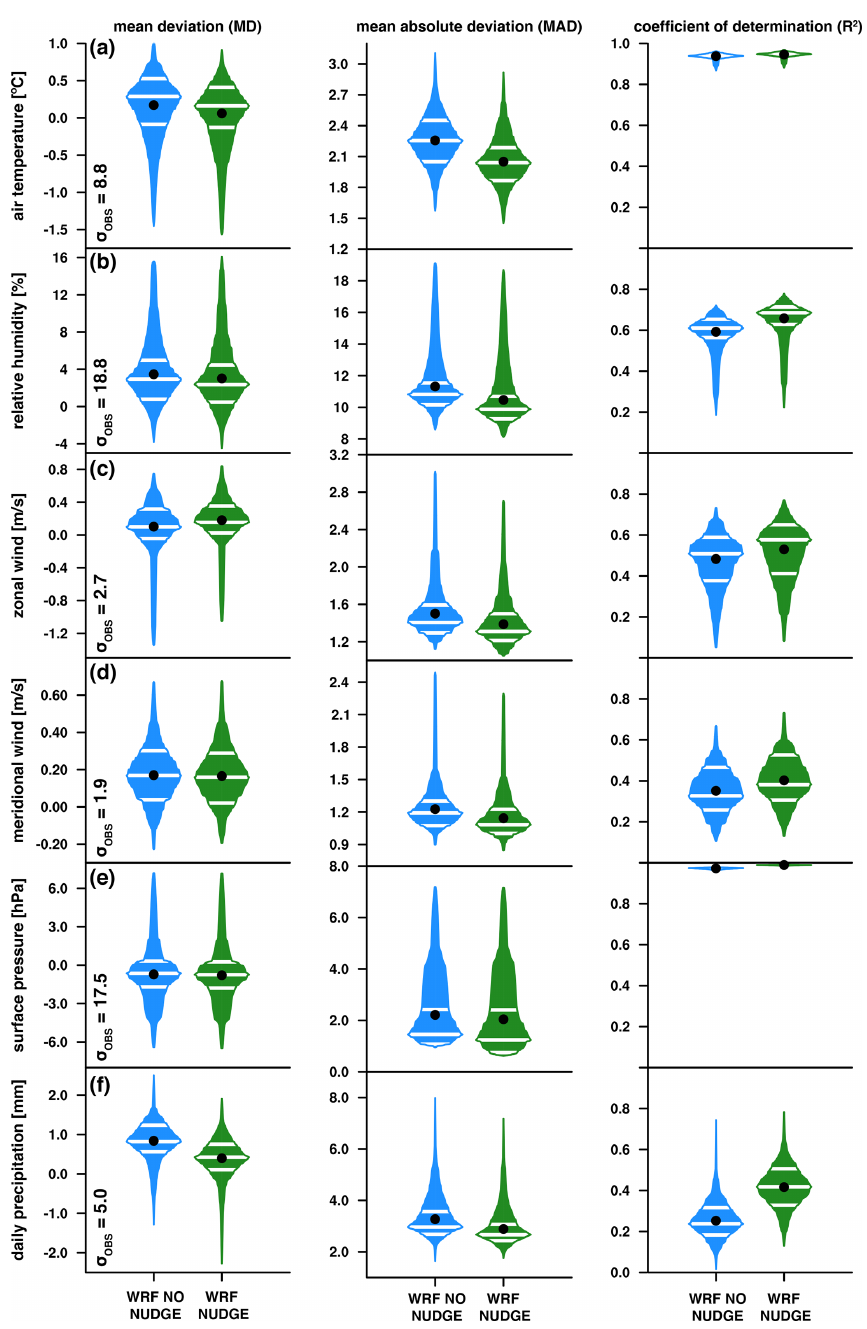
Figure 3. Box-percentile plots (Esty and Banfield, 2003) of mean deviation (MD), mean absolute deviation (MAD), and coefficient of determination ( R 2 ) between observations and the two WRF simulations, WRF_NO_NUDGE (blue) and WRF_NUDGE (green), for 2m (a) air temperature and (b) relative humidity, 10m (c) zonal and (d) meridional winds, (e) surface pressure and (f) precipitation. The statistics for all variables except for precipitation were computed from 2-hourly instantaneous values, while those for precipitation were computed using daily totals. The shape of the plots shows the distribution of data over their range of values; white lines delineate 25th, 50th, and 75th percentiles; and a black dot indicates the mean. The observed standard deviation ( σ obs ) for each variable is provided in the left